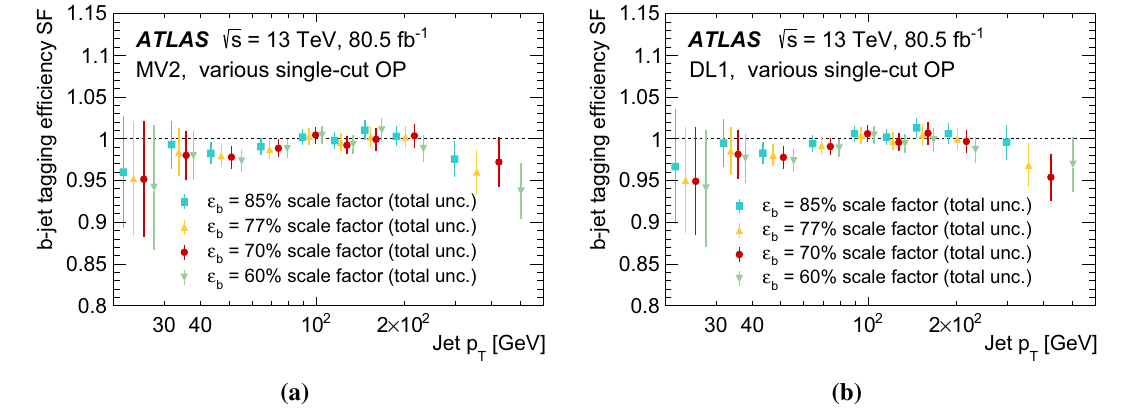
Fig. 9 b -jet tagging efficiency simulation-to-data scale factors as a function of jet p T . The 60%, 70%, 77% and 85% single-cut OP of the (a) MV2 and (b) DL1 taggers are shown. The various groups of points